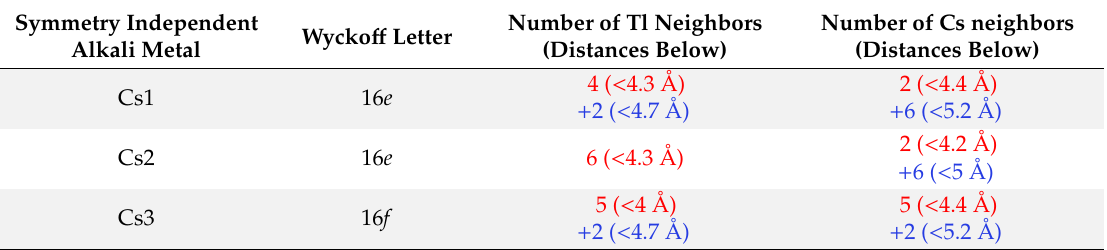
Table 11. Surrounding atoms of the symmetry inequivalent alkali metal positions in CsTl (space group Fddd ). The color-coding refers to the color of the contacts in Figure